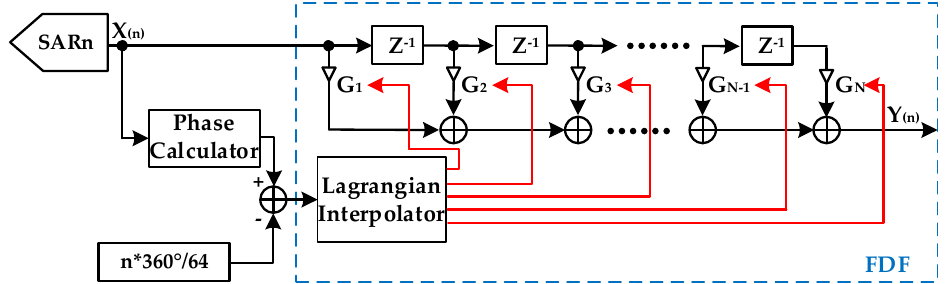
Figure 8. Fine time-skew detector.